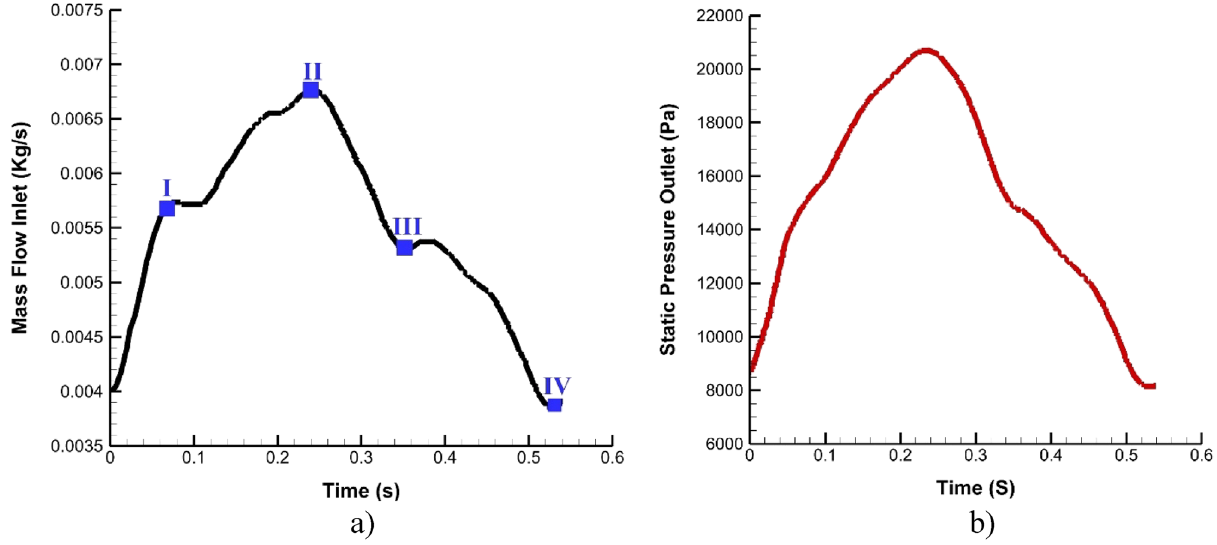
Figure 3. Applied boundary condition at inlets and outlets.